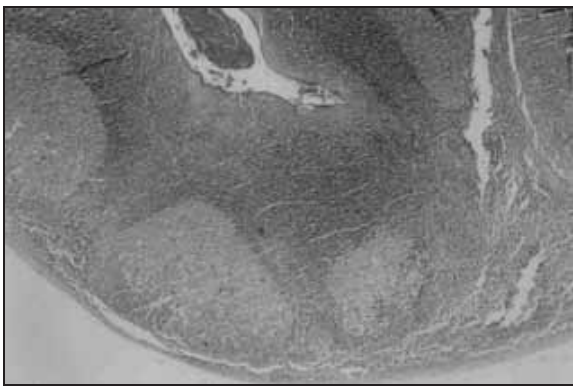
Figura 2 – Fotomicrografia demonstrando a formação de centros germinativos em meio ao intenso infiltrado linfocítico na cápsula fibrosa (HE, 40 × ) HE: hematoxilina e eosina.